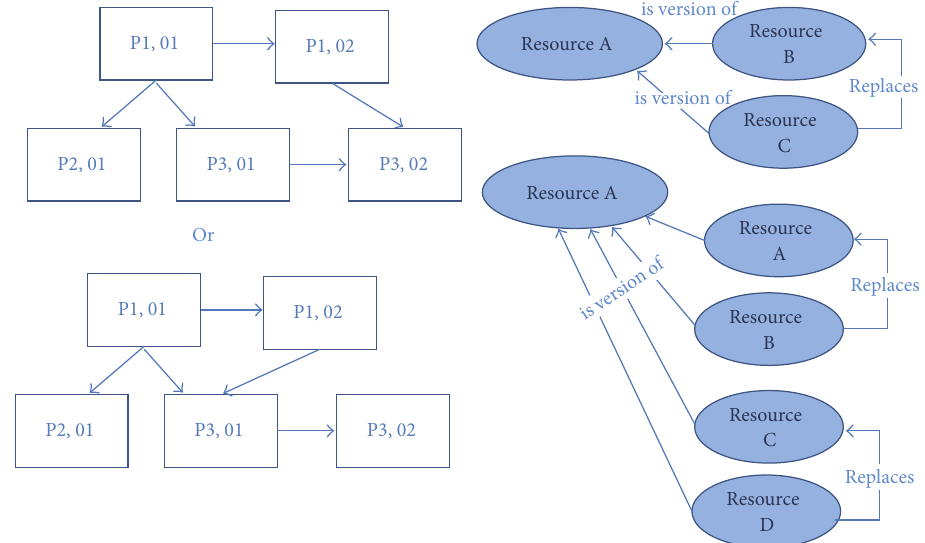
Figure 3: Versioning behaviour of parts when participating in a